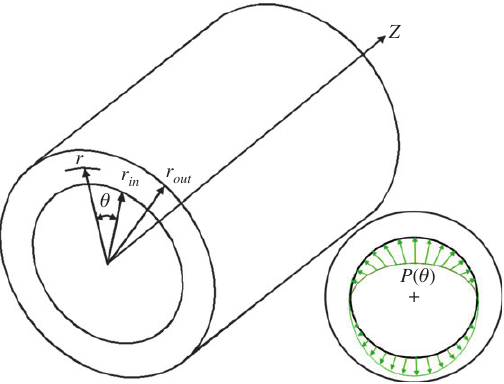
Figure 1 Geometry of the thick hollow FG cylindrical shell subjected to an asymmetric internal